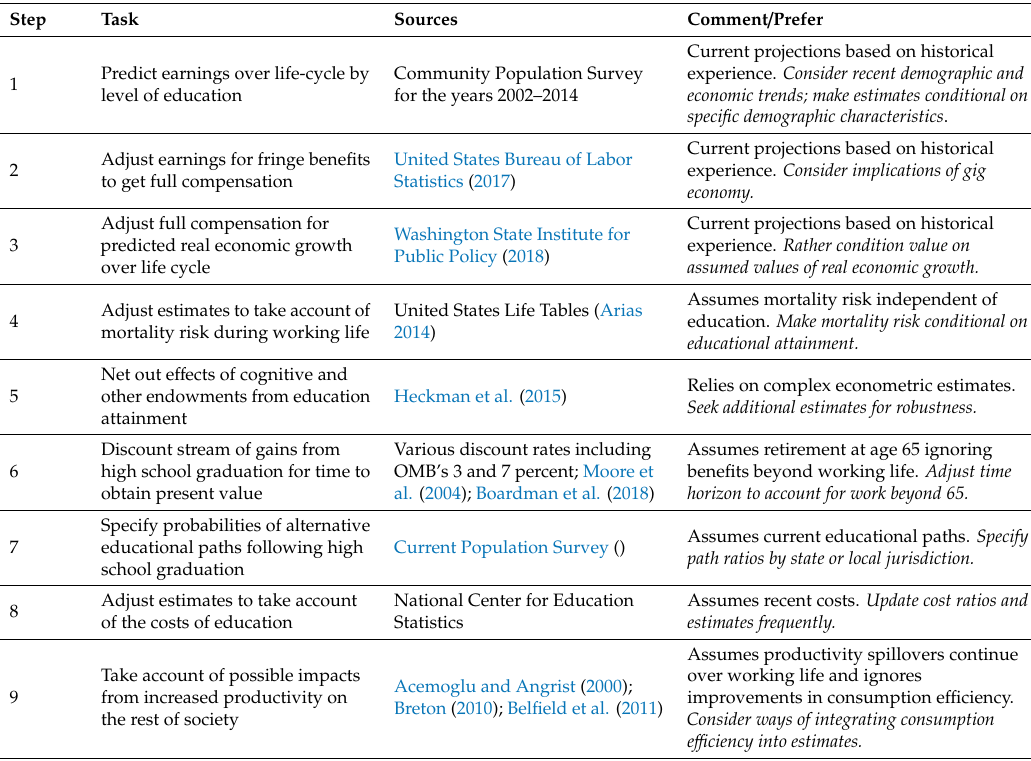
Table 1. Steps in Estimating High School Graduation Shadow